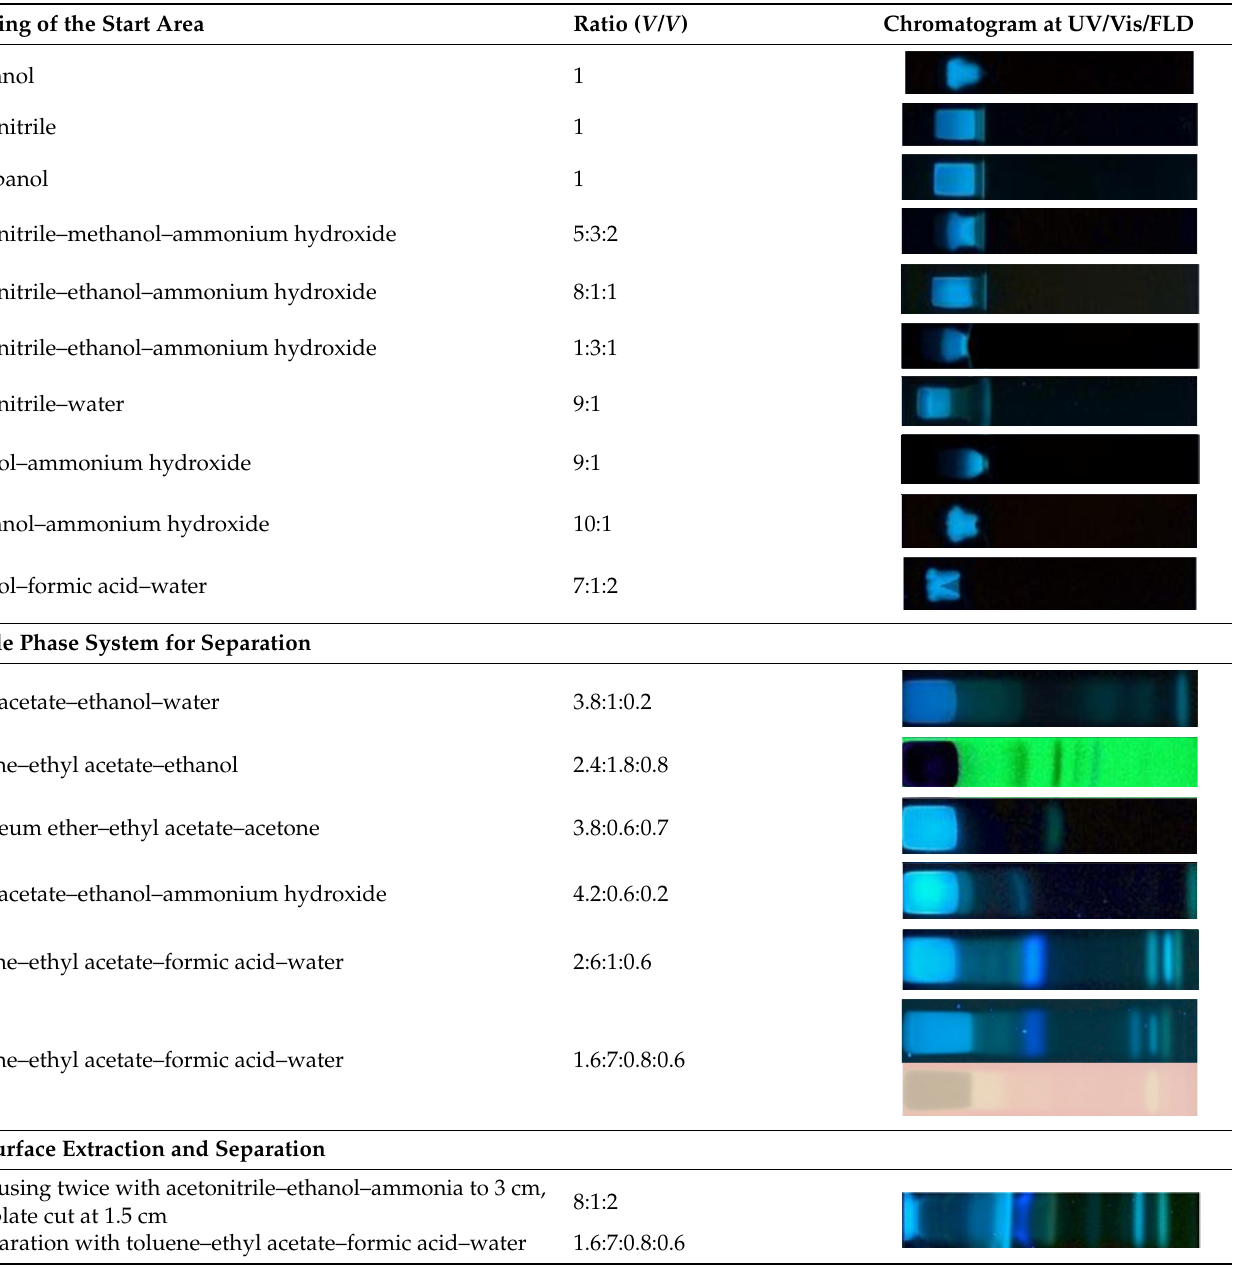
Table 3. On-surface extraction and separation on the same plate: Investigated solvent systems on HPTLC silica gel 60 F 254 plate for focusing of the Coffea arabica honey applied as an area to a sharp start band and for subsequent separation of the compounds, as well as an example of a